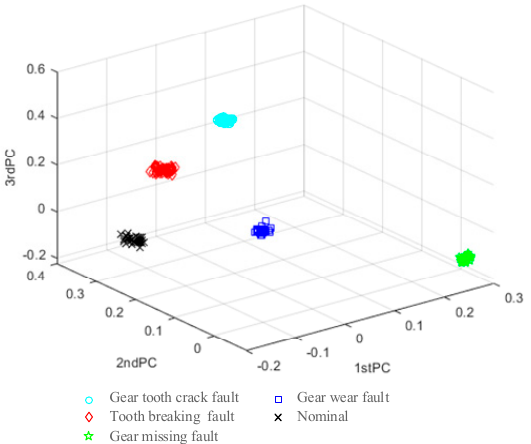
Figure 12. Clustering result of wavelet entropy under condition 2.